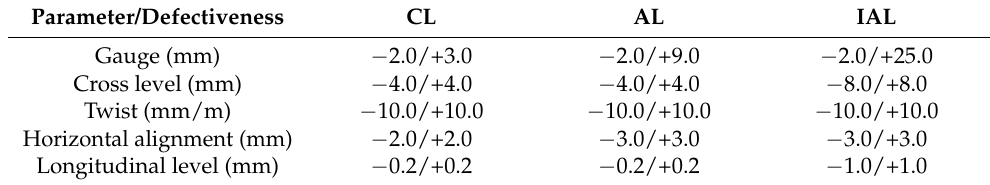
Table 4. Allowable tram-track geometry parameters defectiveness tolerances and established Alert Limits (AL) used in W